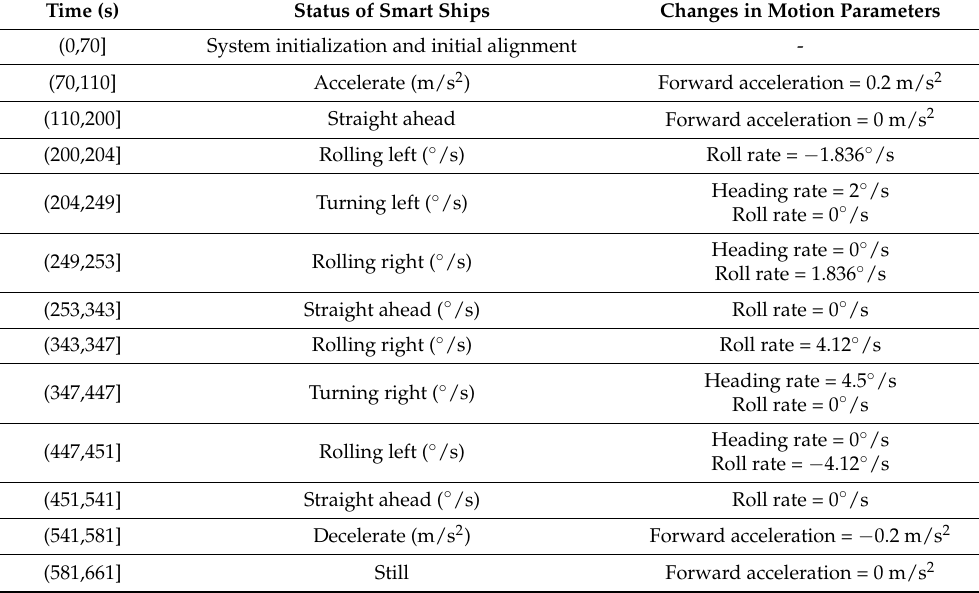
Table 1. Ship motion state and related parameter